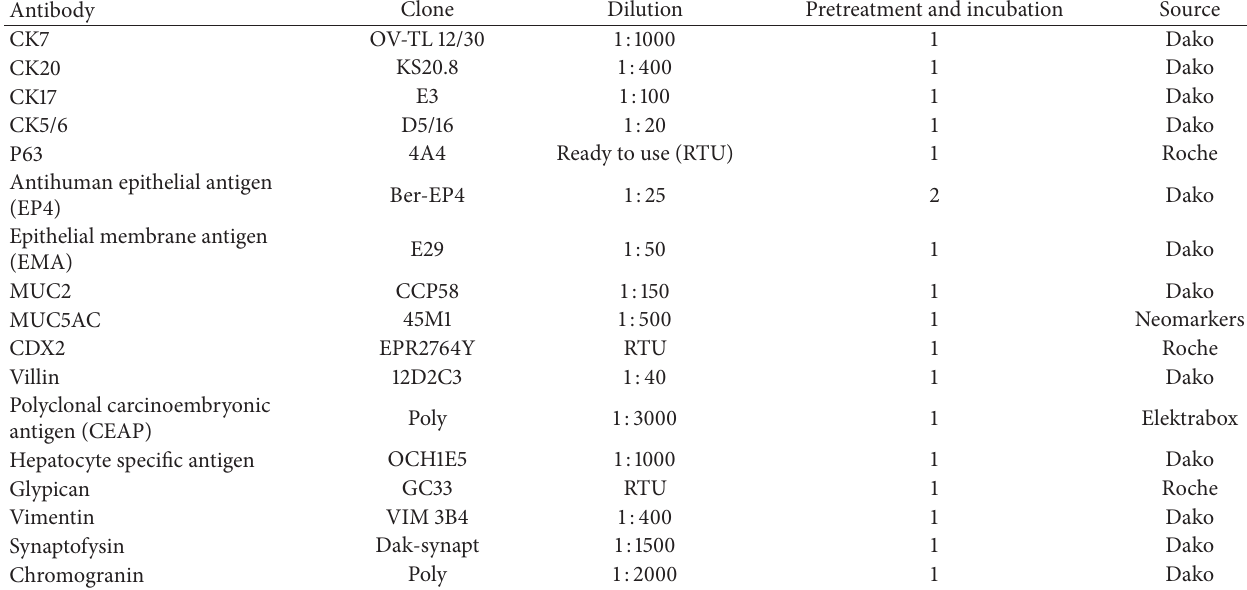
Table 1: Antibodies and their corresponding clone, dilution, pretreatment, incubation methods, and source used for immunohistochemical analysis of the biopsies and resected tissue